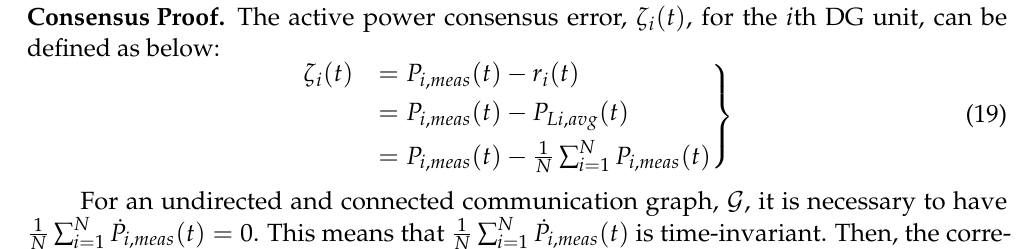
Figure 5. Overall closed-loop implementation of the proposed control